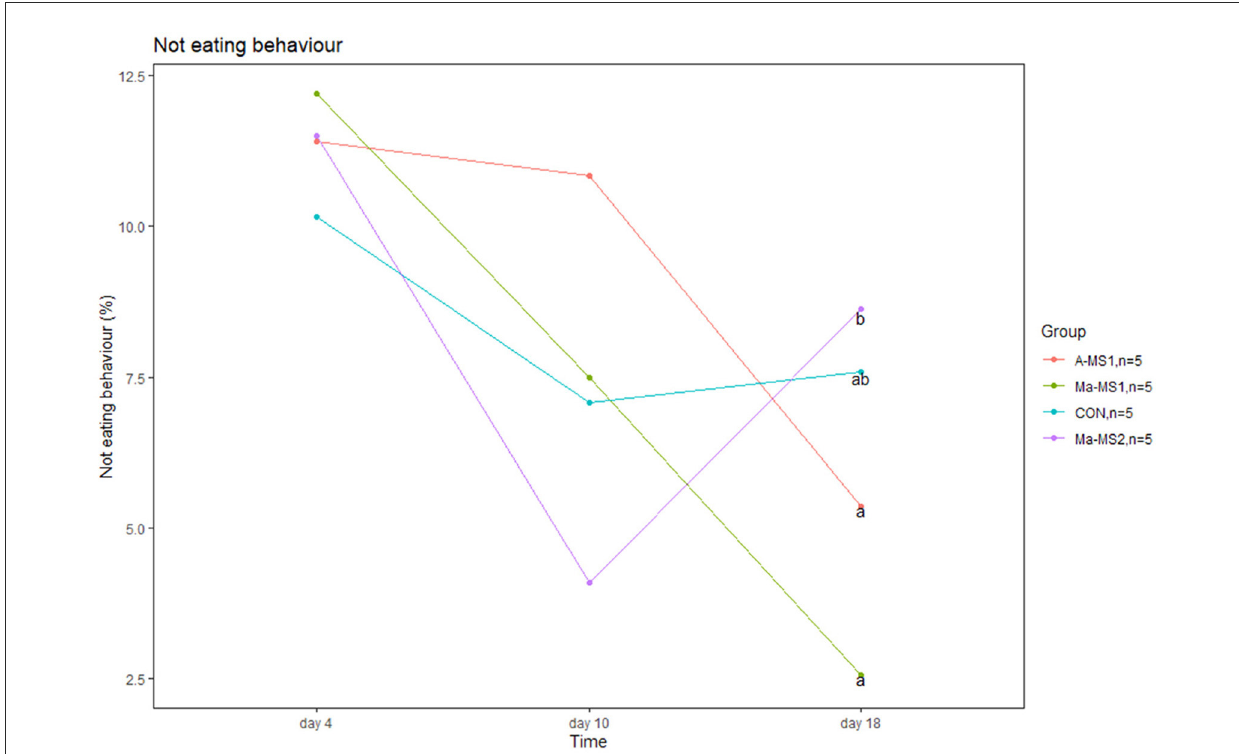
FIGURE1 Line plot showing the percentage of piglets not eating during the suckling event at day 4, 10 and 18 of the trial. a,b values with different superscript differs ( p <